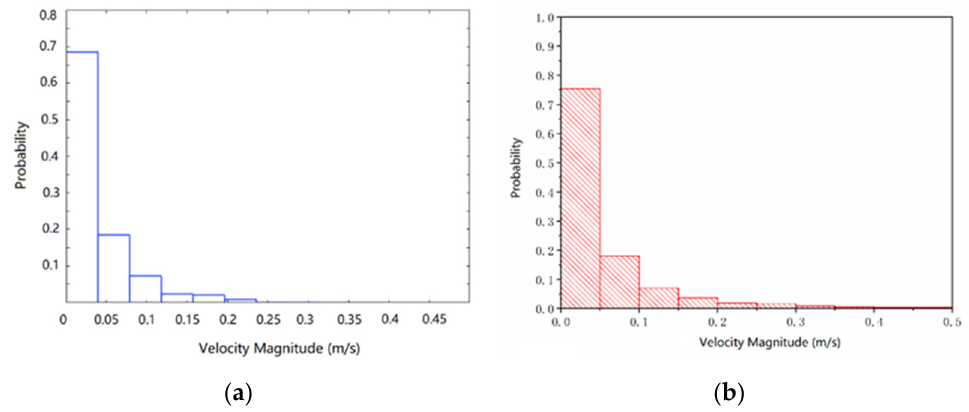
Figure 3. Statistical histogram of liquid phase velocity magnitudes of all grid cells under condition 3: ( a ) simulation result; ( b ) micro-PIV experiment result.